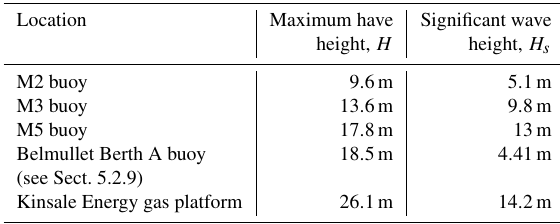
Table 5. Large waves recorded during Storm Ophelia, on 16 Octo- ber